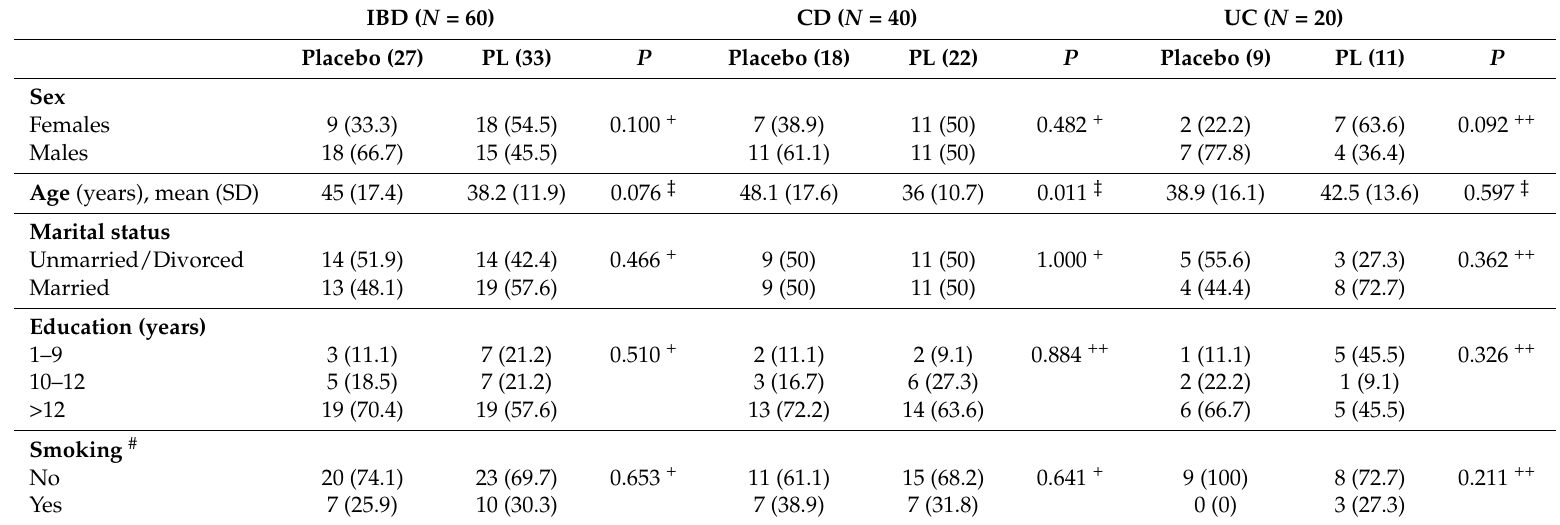
Table 1. Demographics in Inflammatory Bowel Disease (IBD) patients or in the Crohn’s disease (CD) and ulcerative colitis (UC) subgroups. The results are given as N (%) of the total